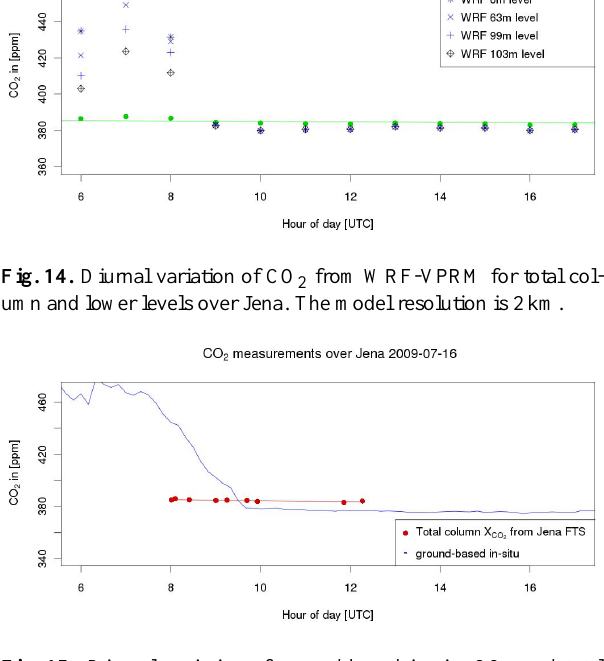
Fig. 15. Diurnal variation of ground-based in-situ CO 2 and total column X CO over Jena. The gaps in the time series are due to 2